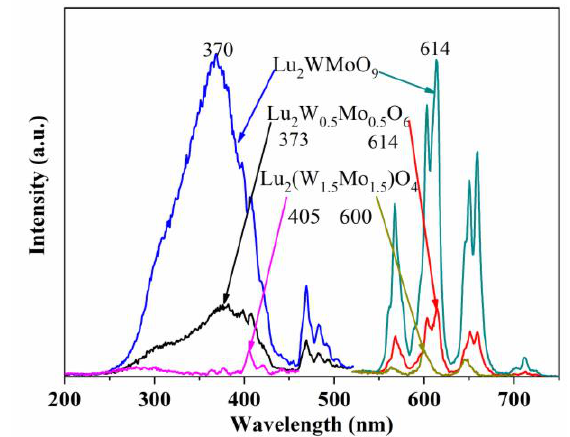
Figure 5. PL excitation ( left part ) and emission ( right part ) spectra of Sm 3+ doped Lu 2 Mo 0.5 W 0.5 O 6 , Lu 2 MoWO 9 , and Lu 2 (Mo 0.5 W 0.5 O 4 ) 3 . For the Sm 3+ doped Lu 2 MoWO 9 presents the strongest PL intensities, the PL excitation and emission spectra of Sm 3+ doping concentration of Lu 2(1-x) Sm 2x MoWO 9 were explored. Figure 6 shows the excitation spectra of Lu 2(1 − x) Sm 2x MoWO 9 by monitoring at Sm 3+ 614 nm emission. With the increase in Sm 3+ concentration, the intensities of the CTB firstly increased, achieved the maximum with the x = 0.03, and then decreased when the x values increased further. For clarity, the x value-dependent CTB intensities are shown in the inset (Figure 6). The results suggest that the optimal x value was 0.03 for CTB